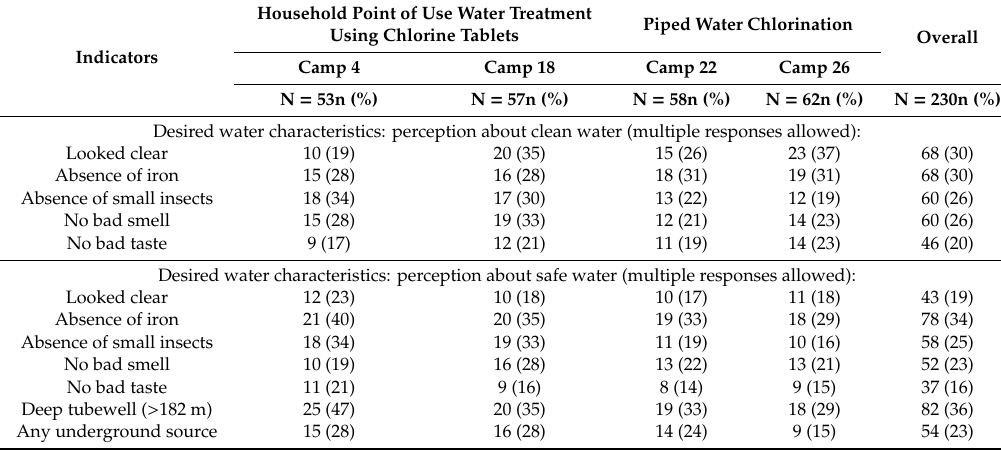
Table 2. Respondents’ perceptions of clean and safe water by